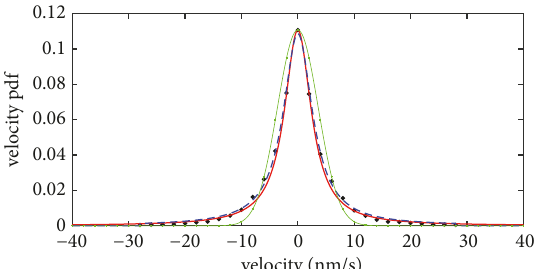
Figure 4: Velocity PDF: the solid line (red) represents the Cauchy-Lorentz distribution, the dashed line (blue) is the truncated Cauchy- Lorentz distribution, the “+” line (green) is the Gaussian distribution, and the black dots are the experimental data, when I=0.1 (tunneling current) and V=0.1 (bias